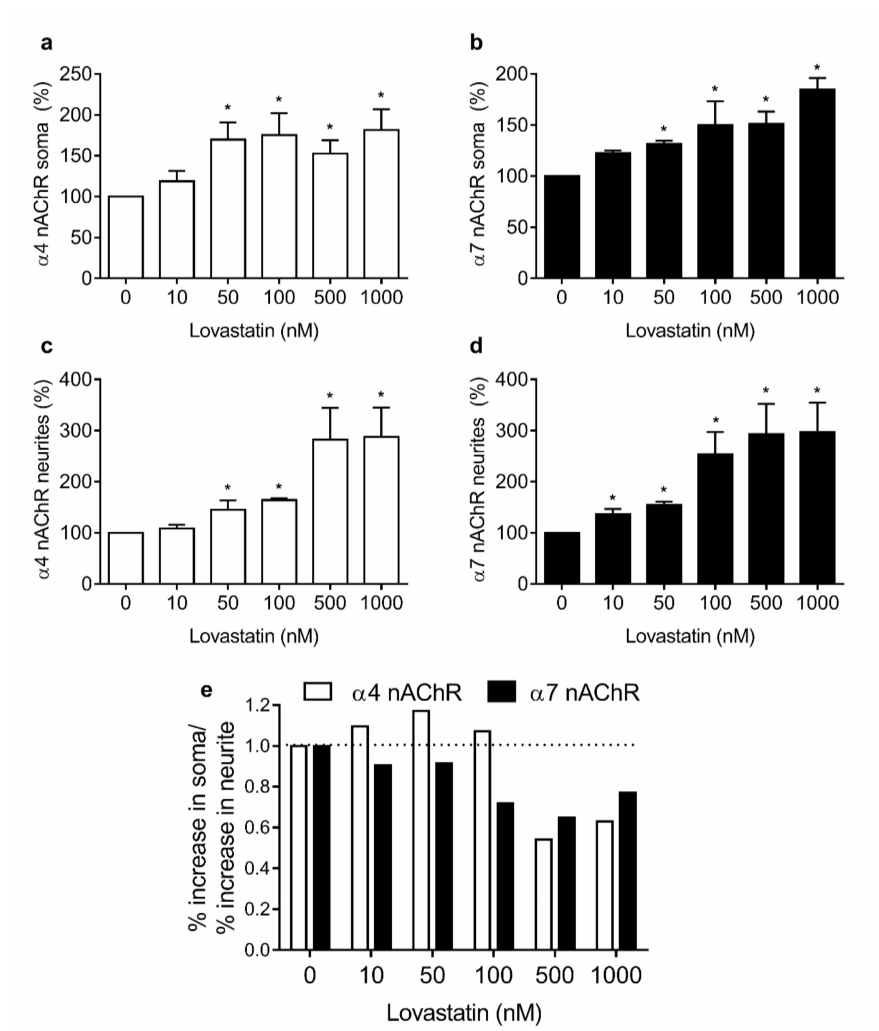
Figure 4. Lovastatin treatment increases surface α 4 and α 7 nAChR levels di ff erentially in soma and neurites. Cultured hippocampal neurons were treated with di ff erent lovastatin concentrations for 14 days. At the end of the incubation neurons were washed, fixed with PF for 15 min, and labeled with Alexa Fluor 488 -BTX and mAb-299 (a primary monoclonal antibody against the α 4 subunit) and Alexa Fluor 555 - secondary antibody. Neurons were washed with phosphate-bu ff ered saline (PBS) and imaged by epifluorescence microscopy. Fluorescence corresponding to Alexa Fluor 555 ( a , c ) and Alexa Fluor 488 -BTX ( b , d ) in soma (upper panel) and neurites (lower panel) was quantified and normalized. Data represent the mean ± SD from at least three independent experiments. * p < 0.01. ( e ) Relative increase in Alexa Fluor 555 (empty bars) and Alexa Fluor 488 -BTX (black bars) fluorescence in soma and